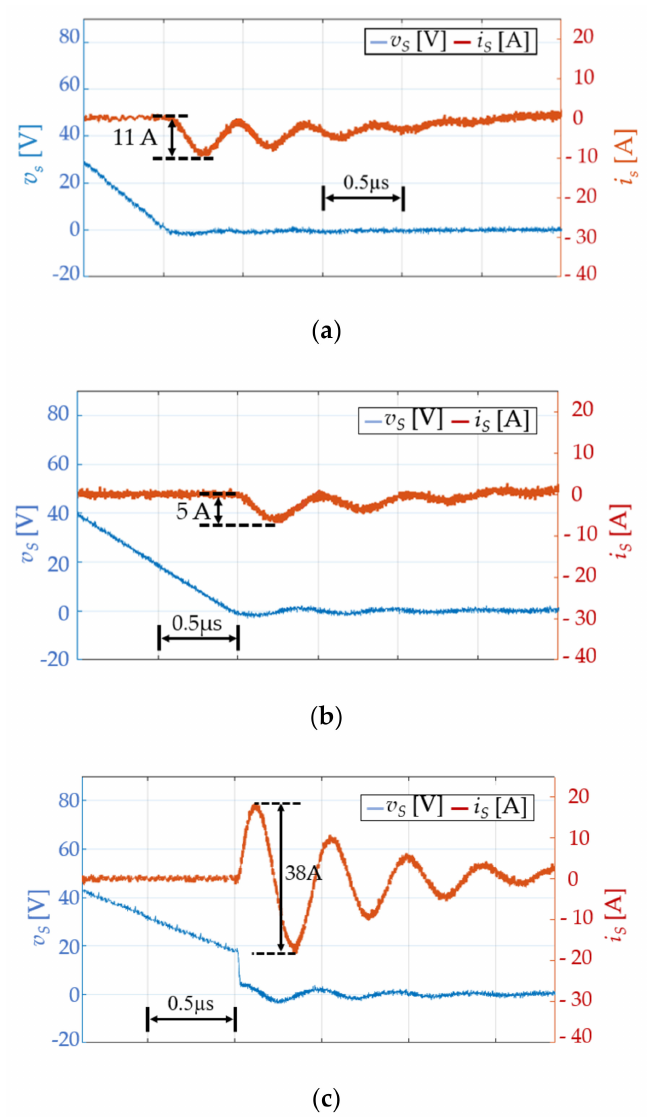
Figure 14. Drain-to-source voltage and current versus C M variation. ( a ) 25 pF. ( b ) 32 pF. ( c ) 45